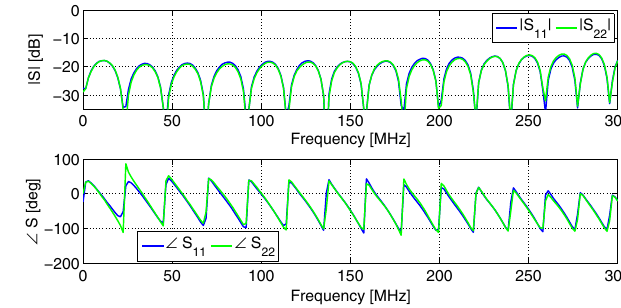
FIG. 13. Modulus and phase of S 11 ml and S 22 ml , normalized to 100 (cid:1)